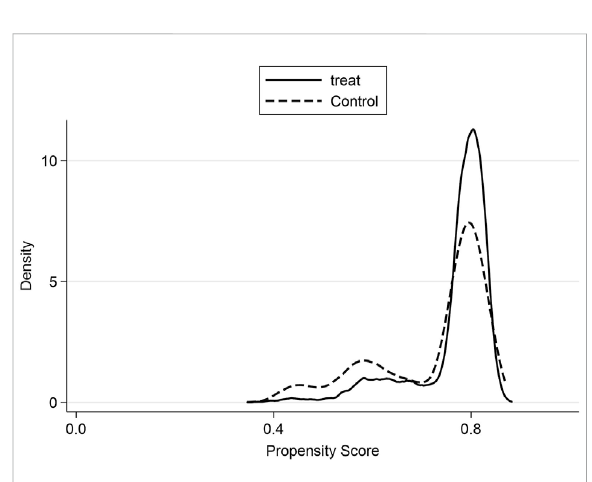
FIGURE 2 Propensity score — probability density plot (after matching).